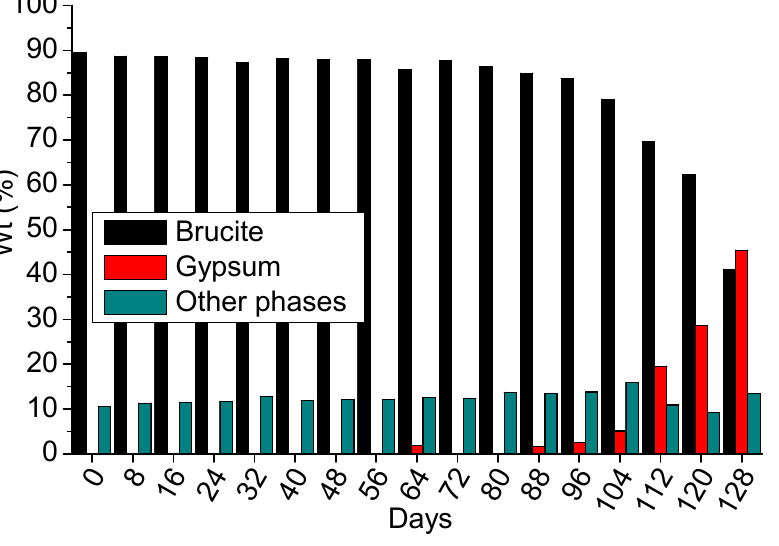
Figure 13. The semi-quantitative results of XRD analysis, regarding the crystalline phases of coated concrete specimens during the application of 4-months acid spraying test.